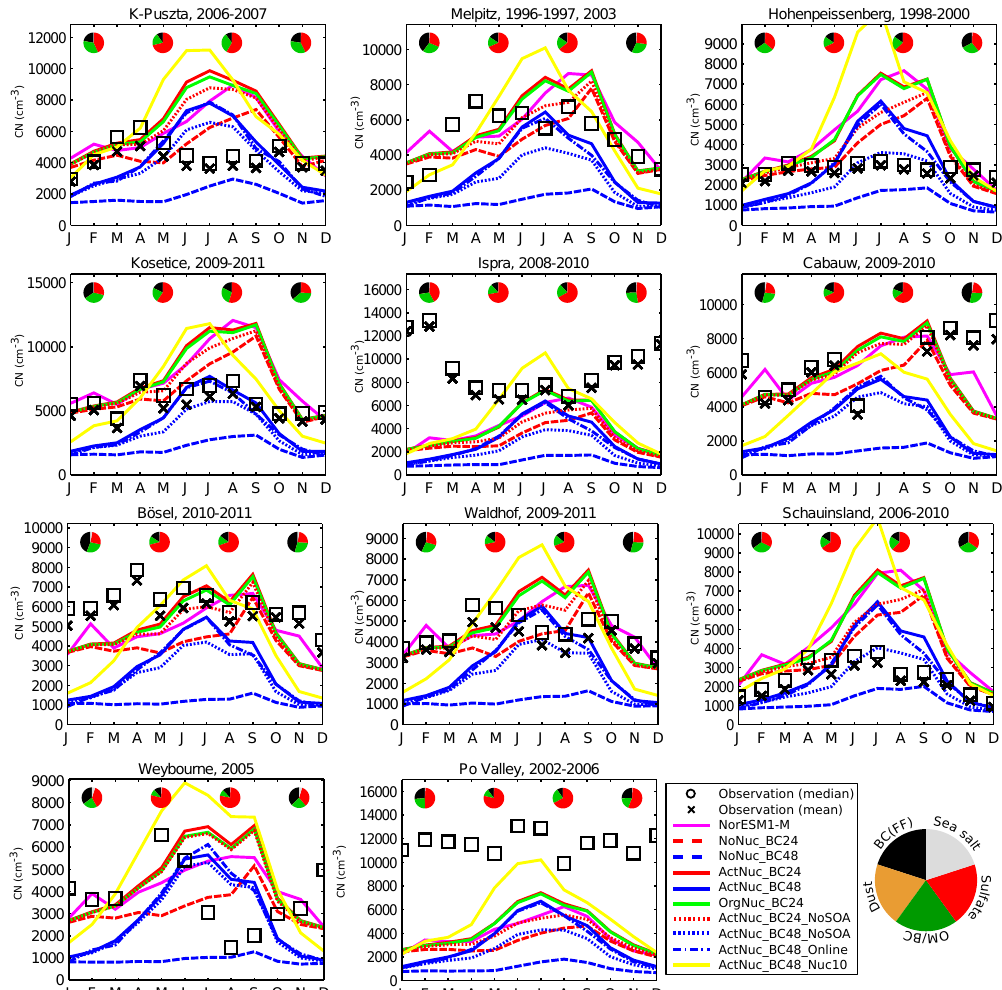
Figure 10. As Fig. 5, but for rural